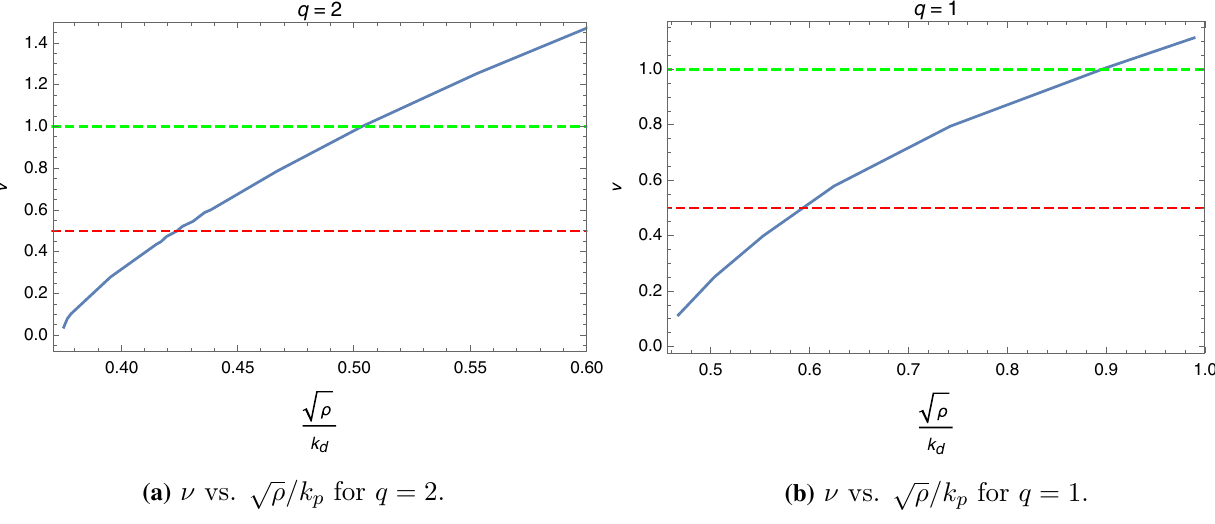
√ ρ/k q = 2. (b) ν vs. ( a ) ν vs. p for √ ρ Fig. 3 ν vs. plot. Red and green dashed line correspond to ν = 1 / 2 and ν = 1 line respectively k p